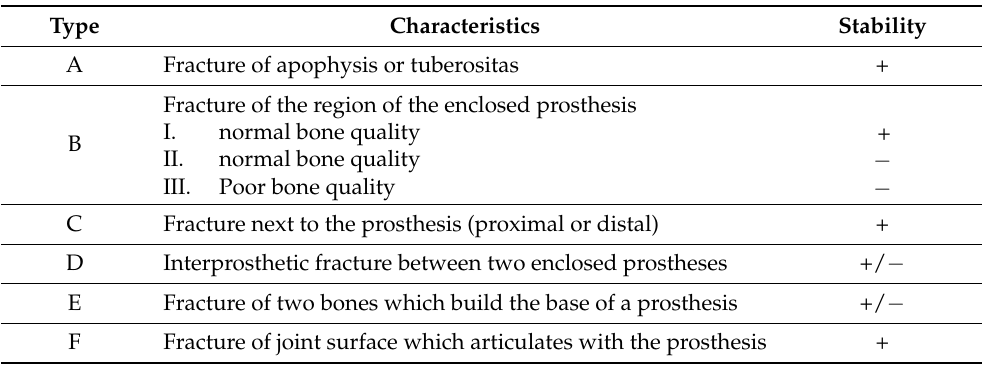
Table 1. Principles of UCS Classification as proposed by Duncan and Haddad—Third part of the classification